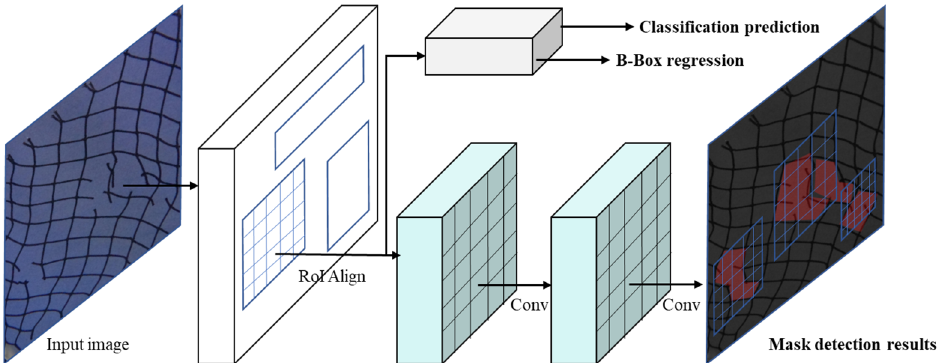
Figure 6. Object detection process.